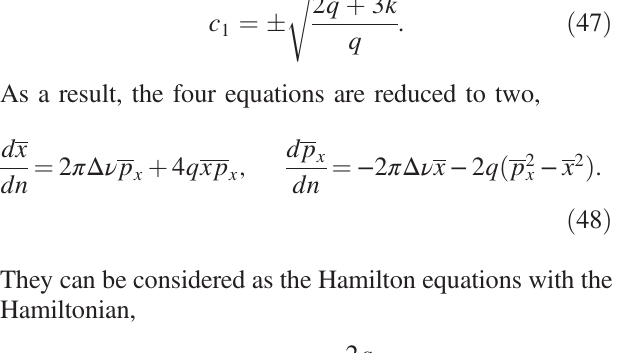
FIG. 10. Invariant tori inside the separatrix in the 4D phase spaces near 1 = 3 resonance with a deviation of Δ ν ¼ 0 . 005 . The red dots represent the orbits from tracking with cell length L ¼ 15 m and angle ϕ ¼ π = 96 and the blue lines are the contours derived from the Hamiltonian in Eq.